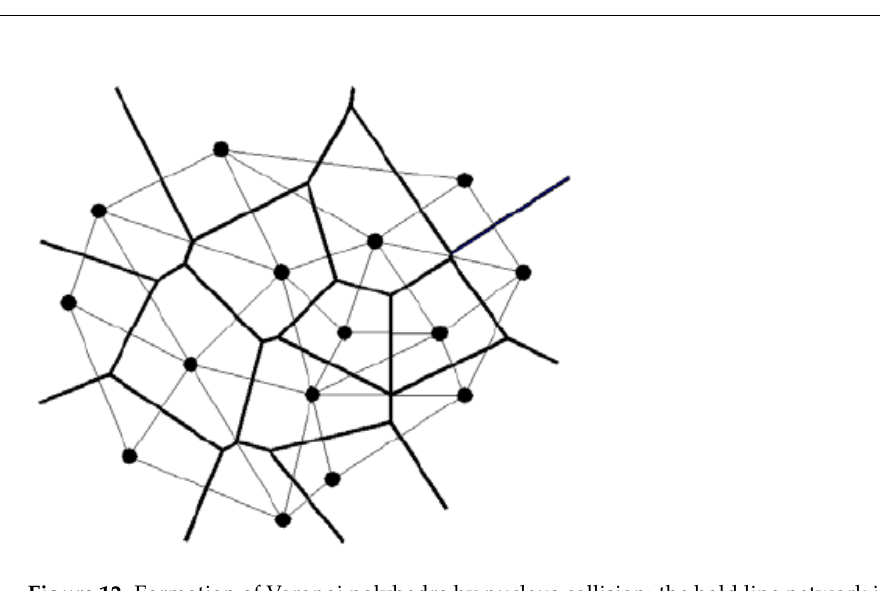
Figure 12. Formation of Voronoi polyhedra by nucleus collision: the bold line network is the Voronoi-diagram reflecting the forming crystals, and the network of thin lines is the Delaunay partition of a two-dimensional system of effective centers of action of the substrate onto the forming film.